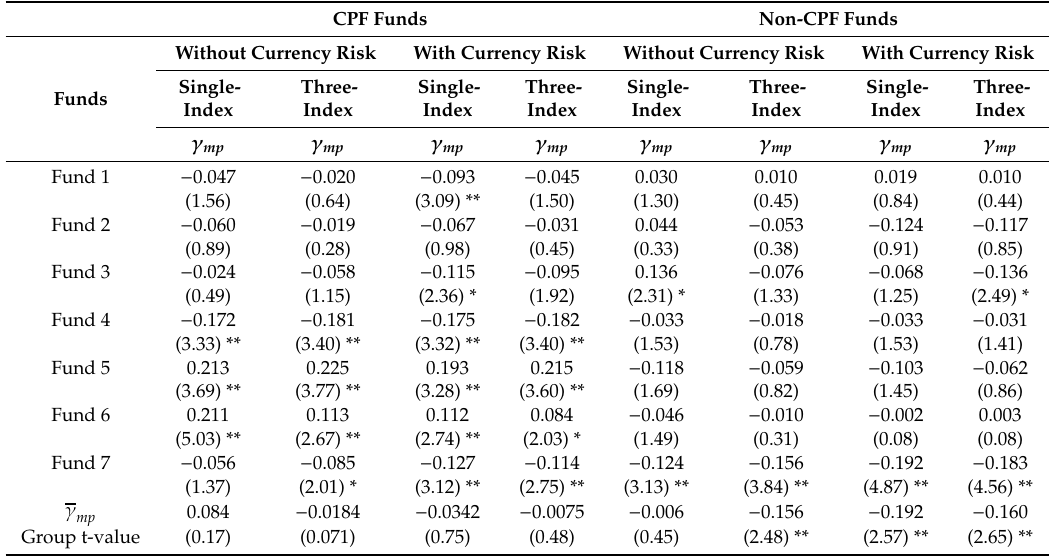
Table 6. Volatility-timing coe ffi cients for global equity funds under the CPF Investment Scheme and non-CPF